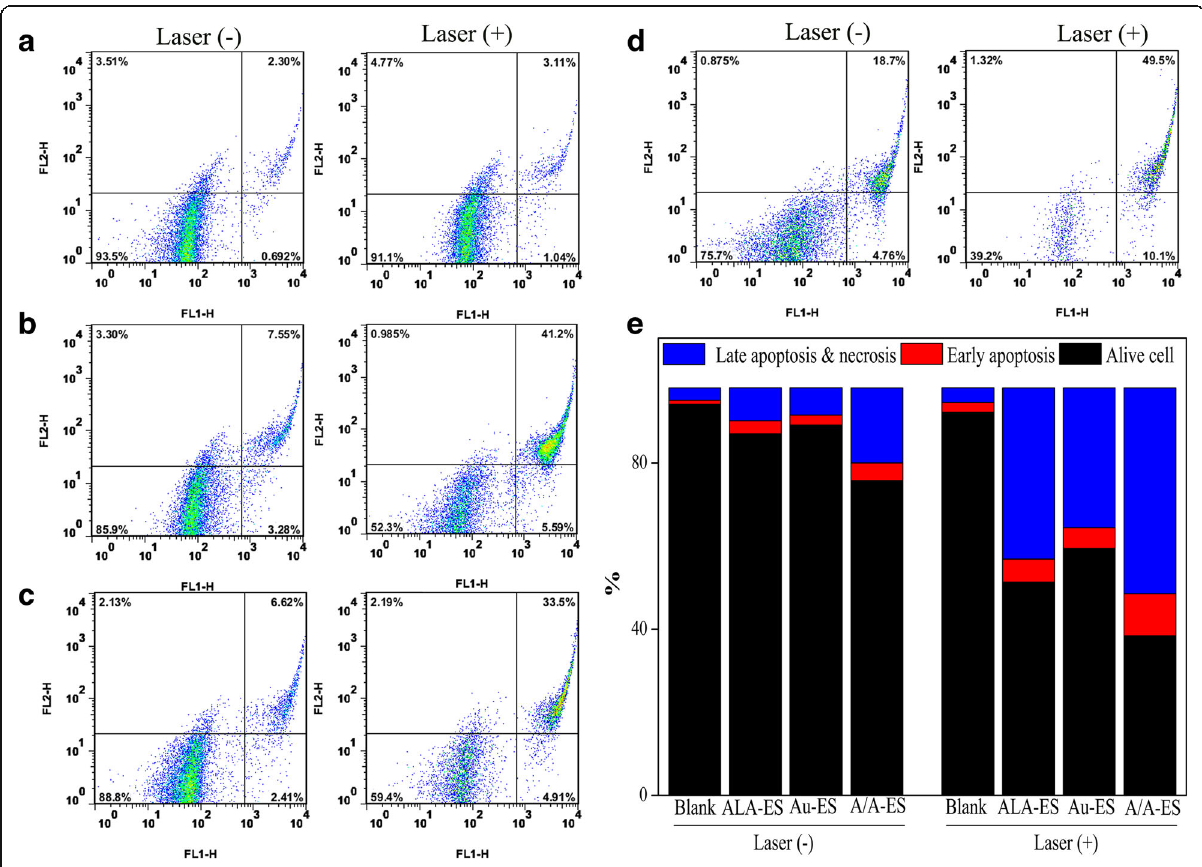
Fig. 6 Apoptosis assay of HSF treated with ALA-ES ( b ), Au-ES ( c ), and A/A-ES without/with laser irradiation ( d ), and the statistical analysis of alive, early apoptotic and late apoptotic and necrosis ( e ). a was the control. Laser (-) and (+) mean without/with laser